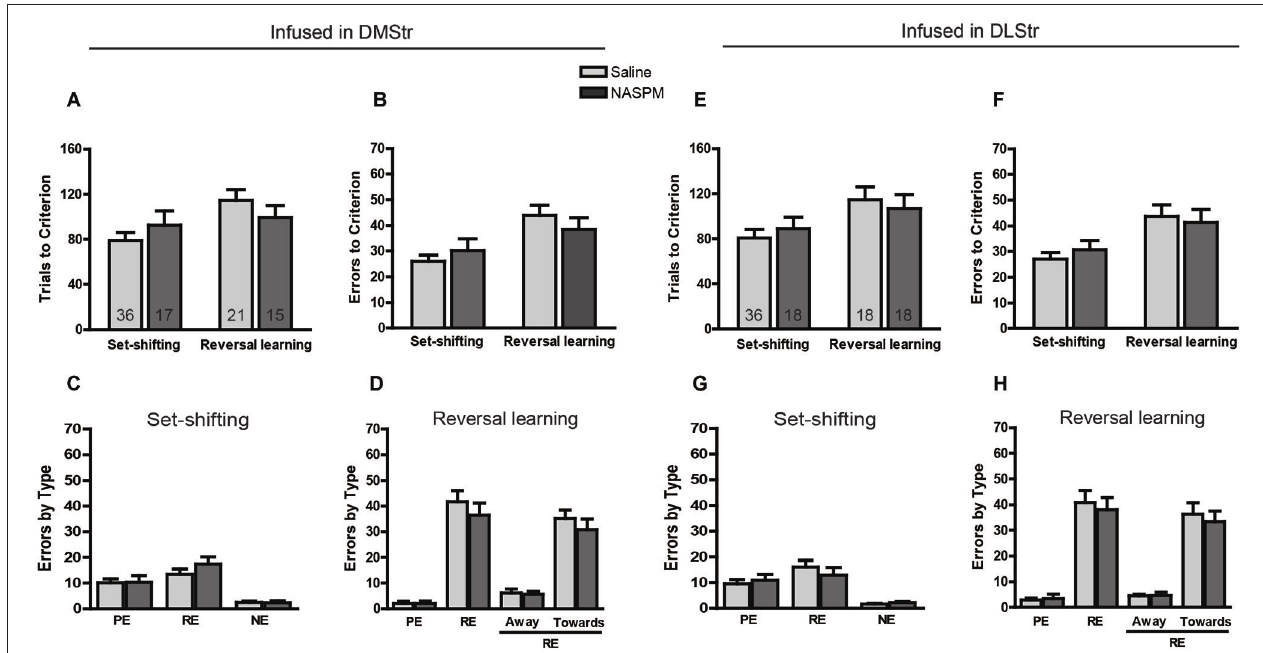
errors during set-shifting (C) and reversal learning (D) in rats that received NASPM treatment in the DMStr. (E) Number of trials and (F) number of errors to reach criterion in the set-shifting and reversal learning tasks following intra-DLStr infusions. (G,H) Analysis of the types of errors during set-shifting (G) and reversal learning (H) in rats that received NASPM treatment in the DLStr. No changes were found in the set-shifting or reversal learning phases. PE, perseverative error; RE, regressive error; NE, non-reinforced error. During the reversal learning task, regressive errors were further divided into “away” and “toward” the visual